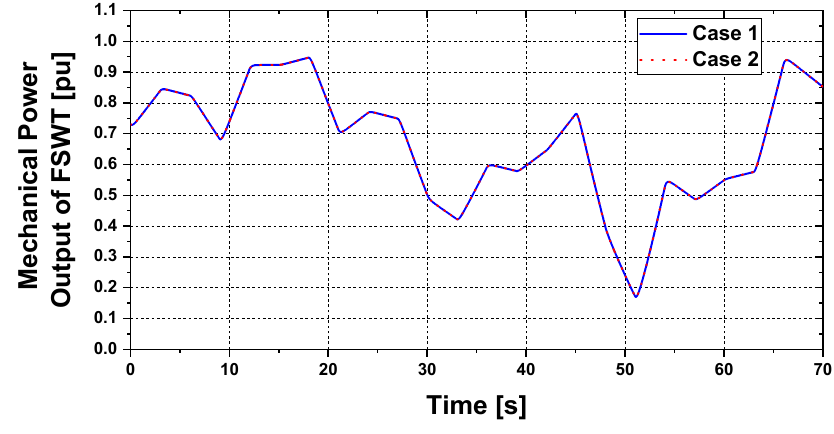
Figure 22. Mechanical power output of FSWT.